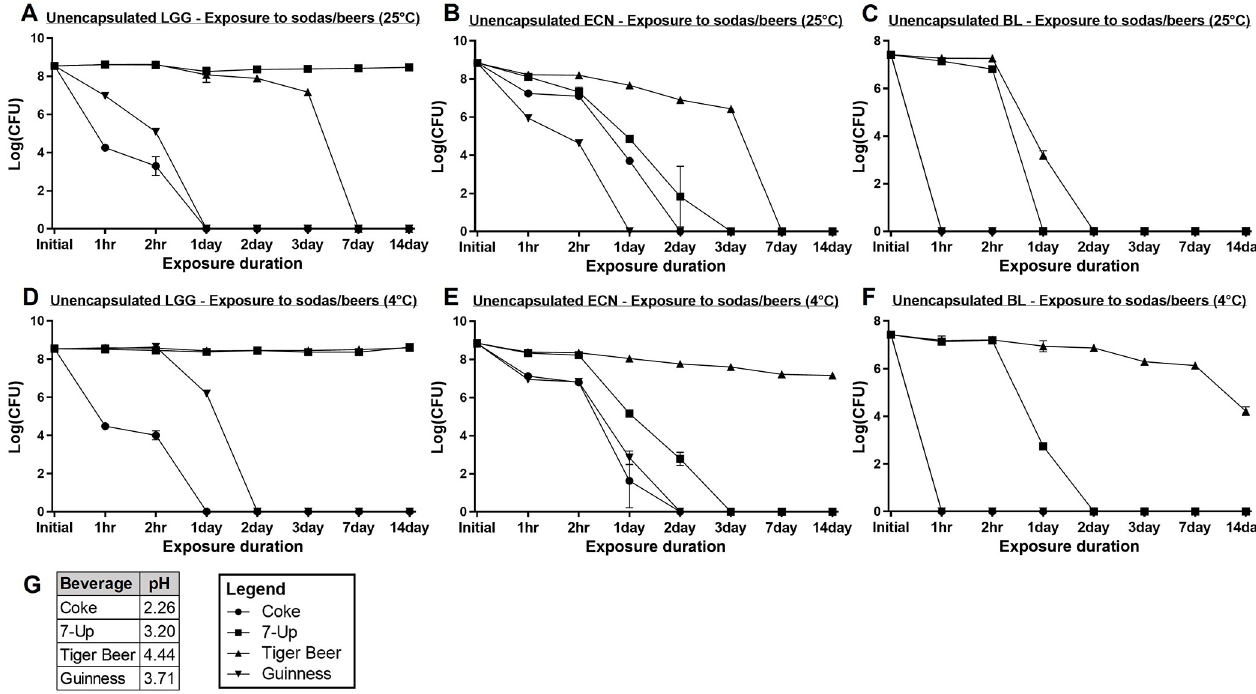
Fig 1. LogCFU survival of unencapsulated probiotics in various beverages at room temperature and refrigerated conditions for up to 14 days. (a) Unencapsulated LGG survival at 25˚C, (b) unencapsulated ECN survival at 25˚C, (c) unencapsulated BL survival at 25˚C, (d) unencapsulated LGG survival at 4˚C, (e) unencapsulated ECN survival at 4˚C, and (f) unencapsulated BL survival at 4˚C; (g) pH values of various beverages measured at room temperature.